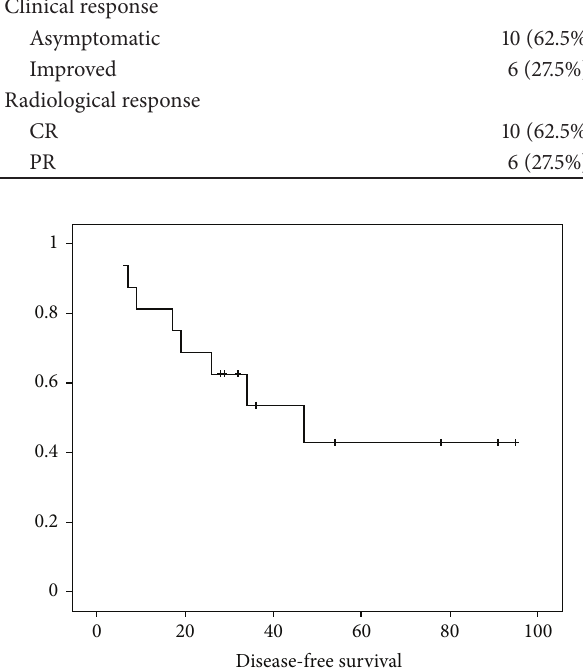
Figure 1: The Kaplan-Meier curve showing disease free-survival (DFS).